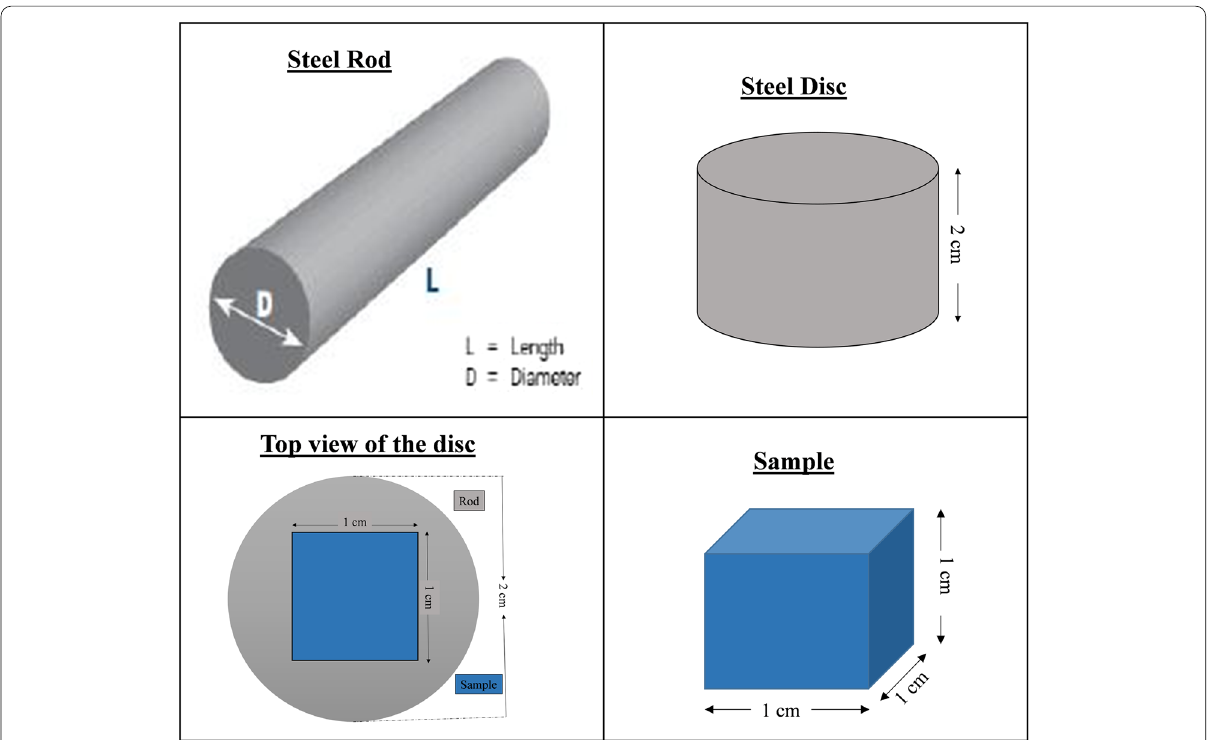
Fig. 1 Schematic representation of sample cutting from